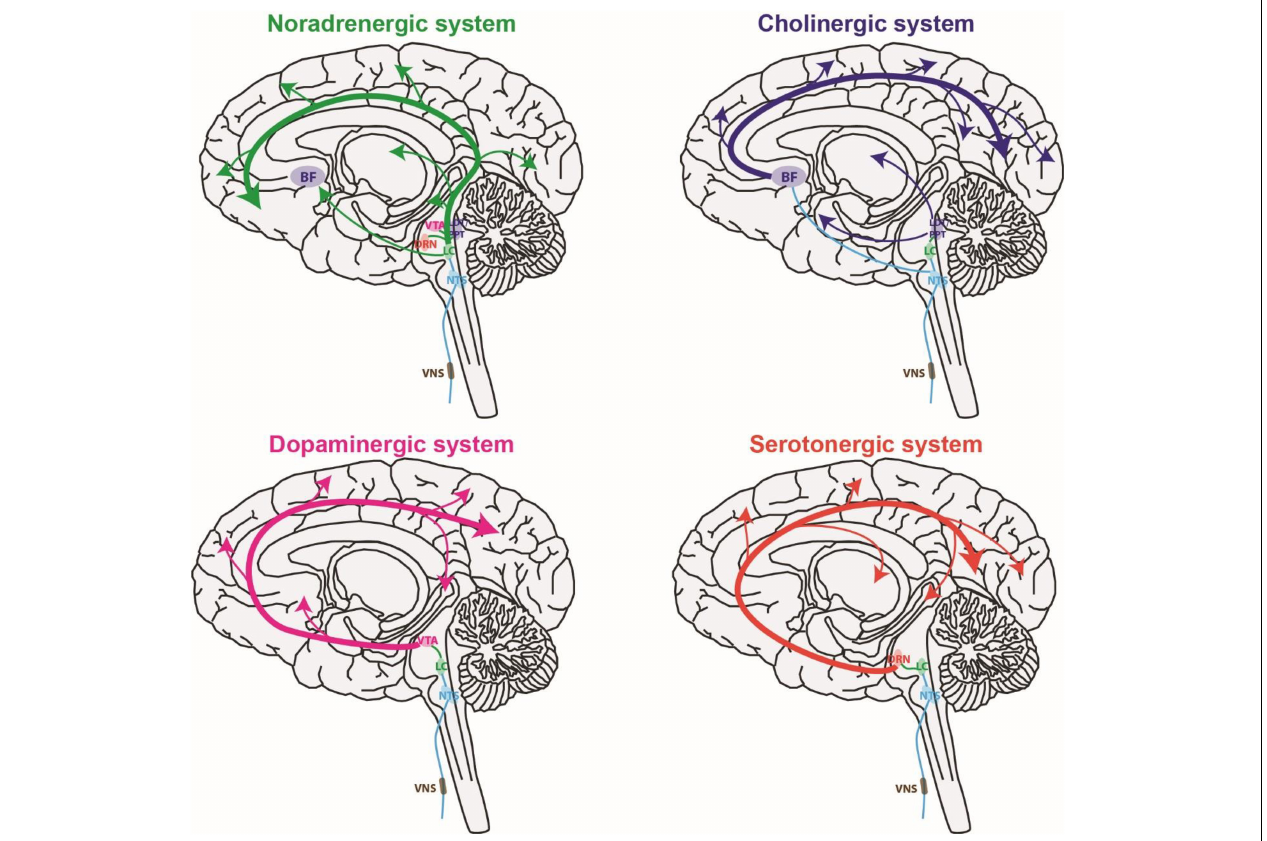
FIGURE 2 | Vagus nerve stimulation activates multiple global neuromodulatory systems that are known to influence sensory processing. BF, basal forebrain; DRN, dorsal raphe nucleus; LC, locus coeruleus; LDT, laterodorsal tegmental nucleus; NTS, nucleus tractus solitaries; PPT, pedunculopontine tegmental nucleus; VTA, ventral tegmental